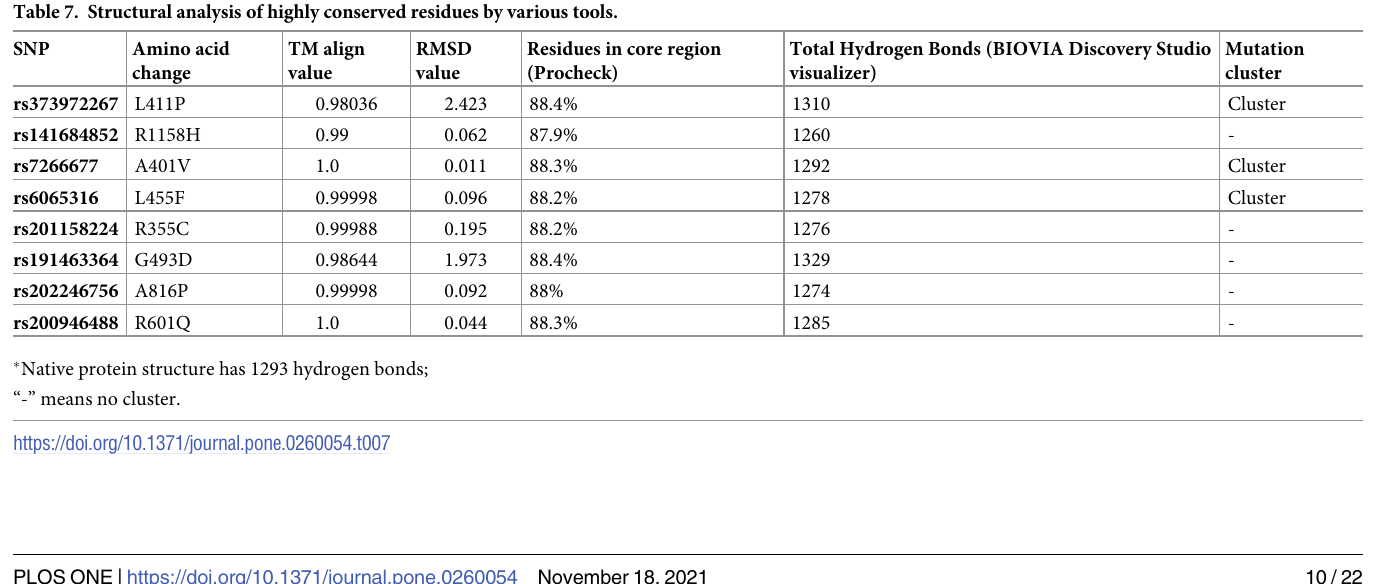
Table 7. Structural analysis of highly conserved residues by various tools.